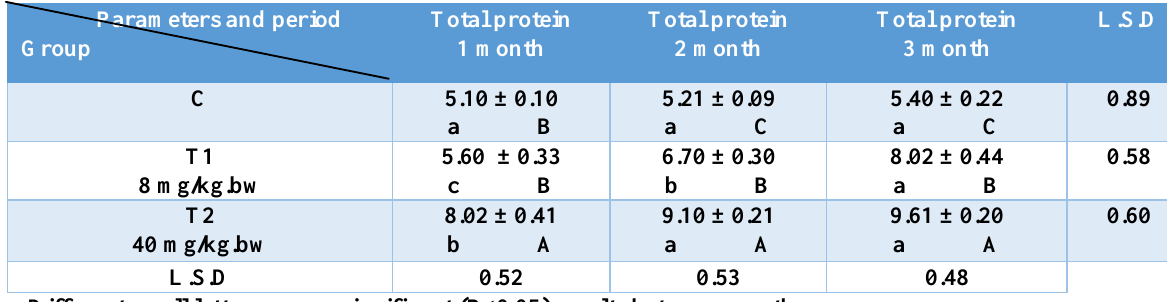
Table, 12: Values of Total protein (g/dl) in serum of rats treated with different doses of CuSO4.5H2O Parameters and